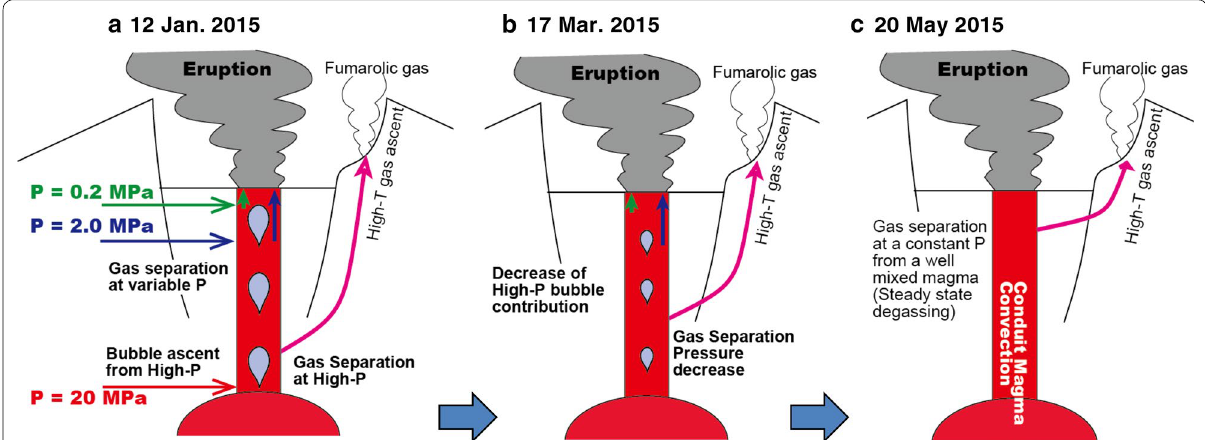
Fig. 12 Schematic diagrams showing the mechanism of the composition variation observed during the eruptive period. a On 12 January 2015, gases discharge during intensive ash eruptions are derived from a wide range of pressure from 20 to 0.2 MPa, causing a rapid and large variation in gas composition, in particular of CO 2 /SO 2 and SO 2 /H 2 S ratios. The fumarolic gases likely be derived from gases separated at a high pressure. b On 17 March, the rapid and large variation of gas composition indicates bubble ascent from a wide range of pressure. But decrease in the composition range suggests decrease in the maximum degassing pressure and decrease in contribution of bubbles formed at a high pressure. c On May 2015, the stable gas composition implies degassing of a well-mixed magma under a stable